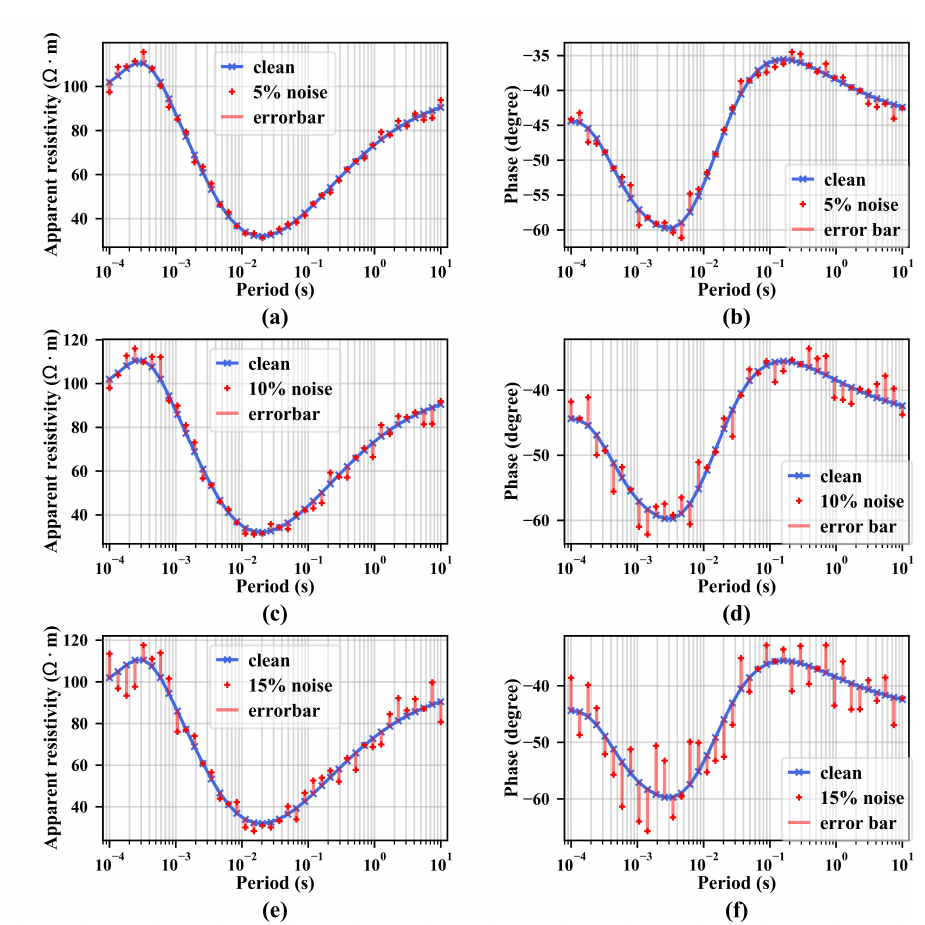
Figure 9. Supposed MT responses of a three-layer geoelectric model with different levels of noise. ( a , b ) represent the MT responses when the noise level is 5%. ( c , d ) represent the MT responses when the noise level is 10%. ( e , f ) represent the MT responses when the noise level is 15%. ( a , c , e ) represent the apparent resistivity responses. ( b , d , f ) represent the apparent resistivity responses. The blue lines represent the clean supposed responses. The red dots indicate the noisy responses. The red lines are the error bars between the noisy data and clean